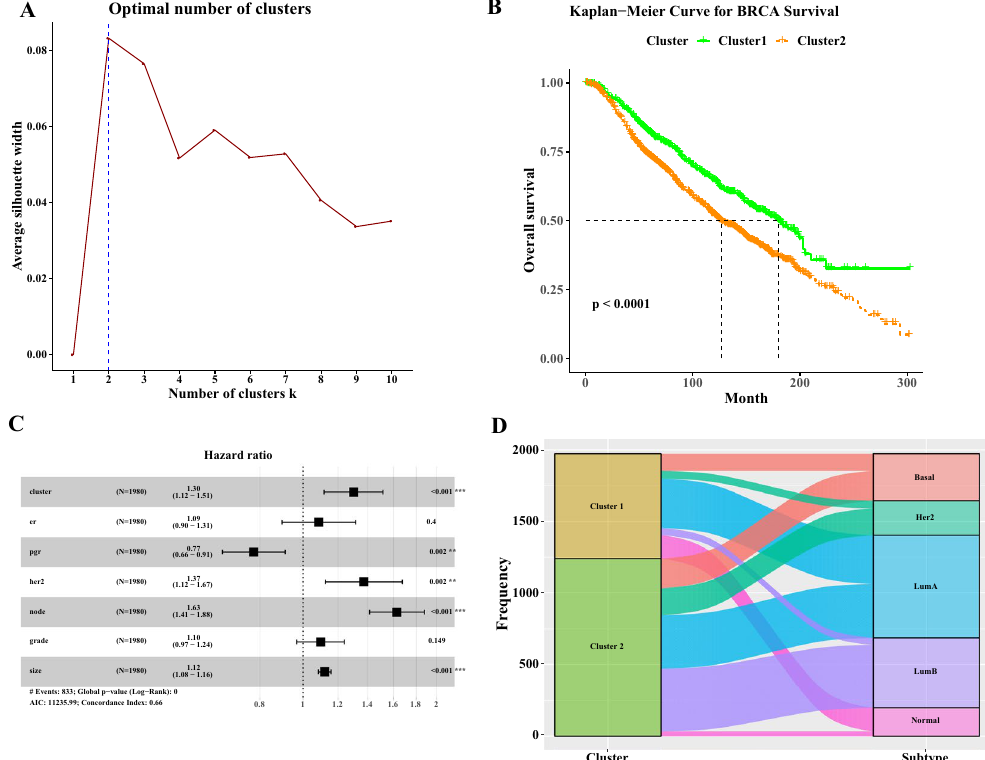
Figure 2. The cluster analysis of breast cancer. ( A ) The silhouette width analysis of the clustering by using the expression profiles of 117 immune-related genes. (B) Kaplan-Meier estimate of the overall survival for cluster 1 and cluster 2 patients. (C) The multivariable cox regression analyses in breast cancer patients. (D) Alluvial diagram for cluster 1 and cluster 2 versus different subtypes in in breast cancer